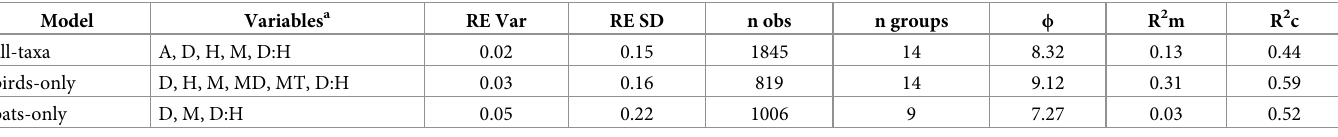
Table 5. For each global model, variables, random effect variance (RE Var) and standard deviation (RE SD) of the facility ID random effect, number of observa- tions, number of wind facilities (n groups), dispersion parameter ( ϕ ), marginal pseudo R 2 (R 2 m), and conditional pseudo R 2 (R 2 c). Model